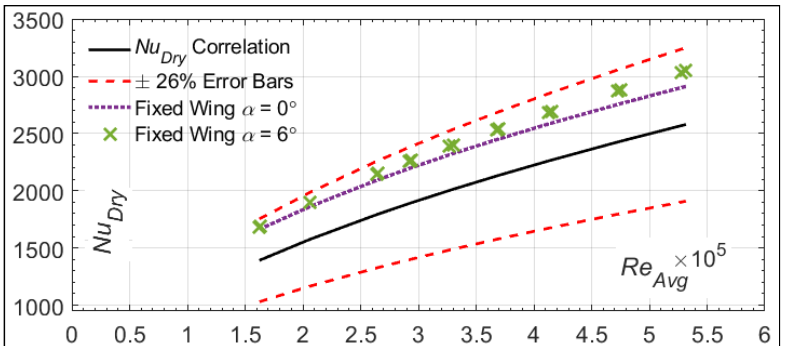
Figure 20. Comparison of Nu Dry Correlation Predictions Versus Proposed Correlations from the Literature.